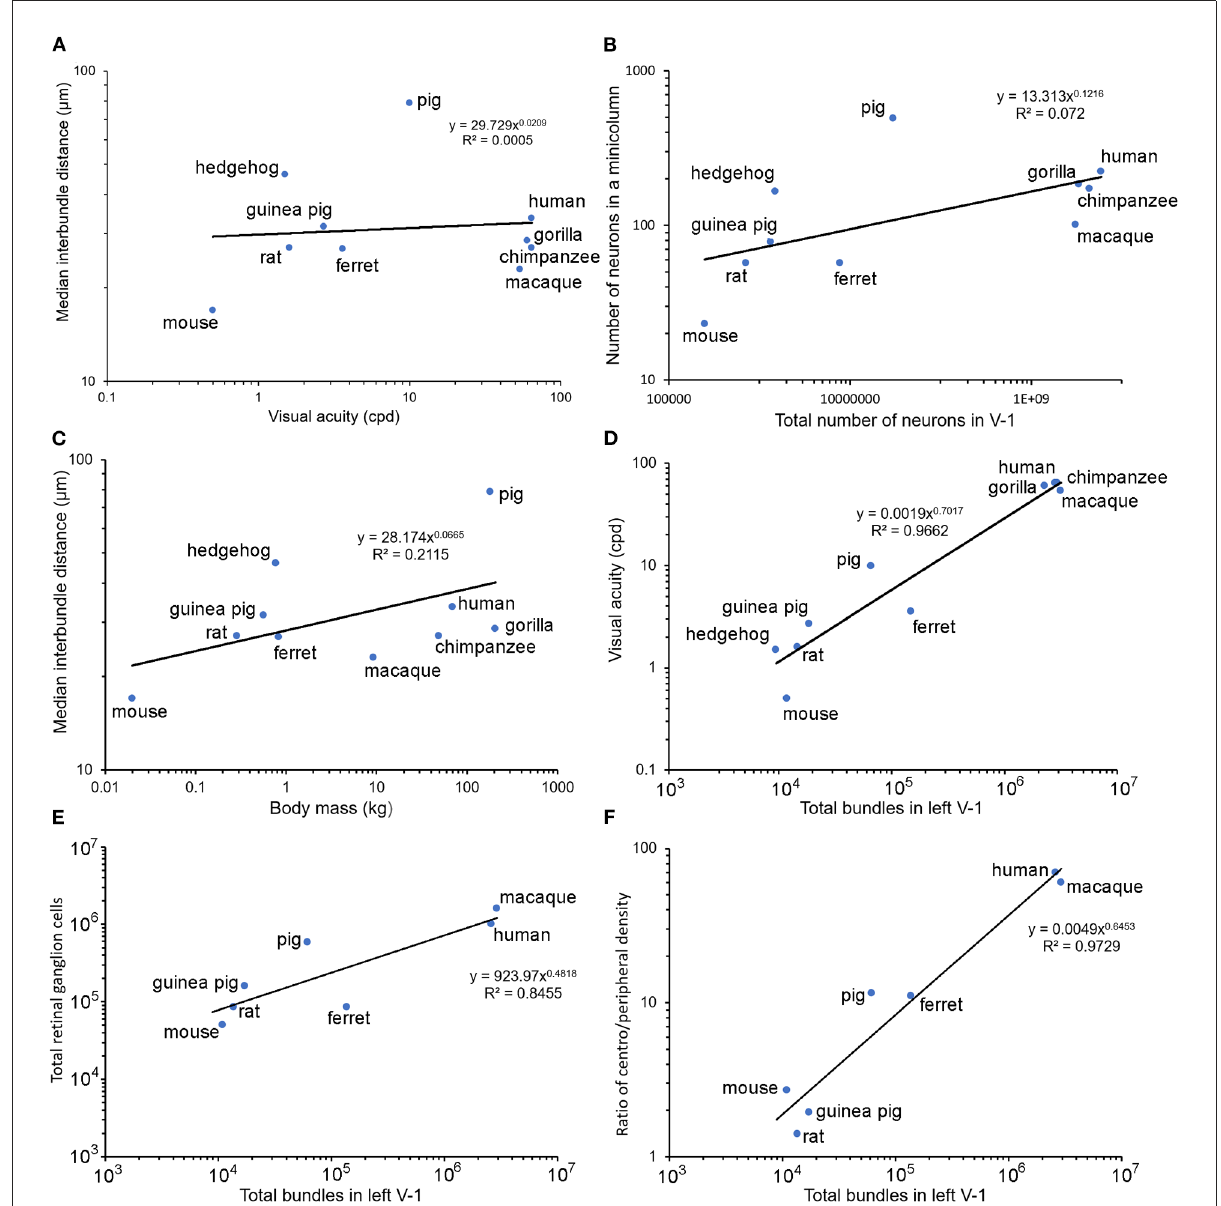
FIGURE5 Pairs of relevant parameters are plotted against each other on log/log axes for each of the seven species used in the current study where available, along with values for the macaque monkey, rat and mouse published previously by others. Panel (A) shows a lack of any clear relationship between visual acuity (cycles per degree) and the median interbundle distance. Panel (B) also shows a lack of any overall correlation between the estimated total number of neurons in V-1 and the number within a single minicolumn. There is only a weak correlation between body mass and median interbundle distance (C) . However, when the total number of bundles in the left V-1 is plotted against visual acuity (D) there is a strong correlation overall ( R 2 = 0.97). A similar tight relationship is shown between the total number of retinal ganglion cells and myelin bundles in V-1 (E) . An even better correlation is seen when the ratio of the density of ganglion cells in the fovea/area centralis to the peripheral retinal density is plotted against myelin bundles (F) .